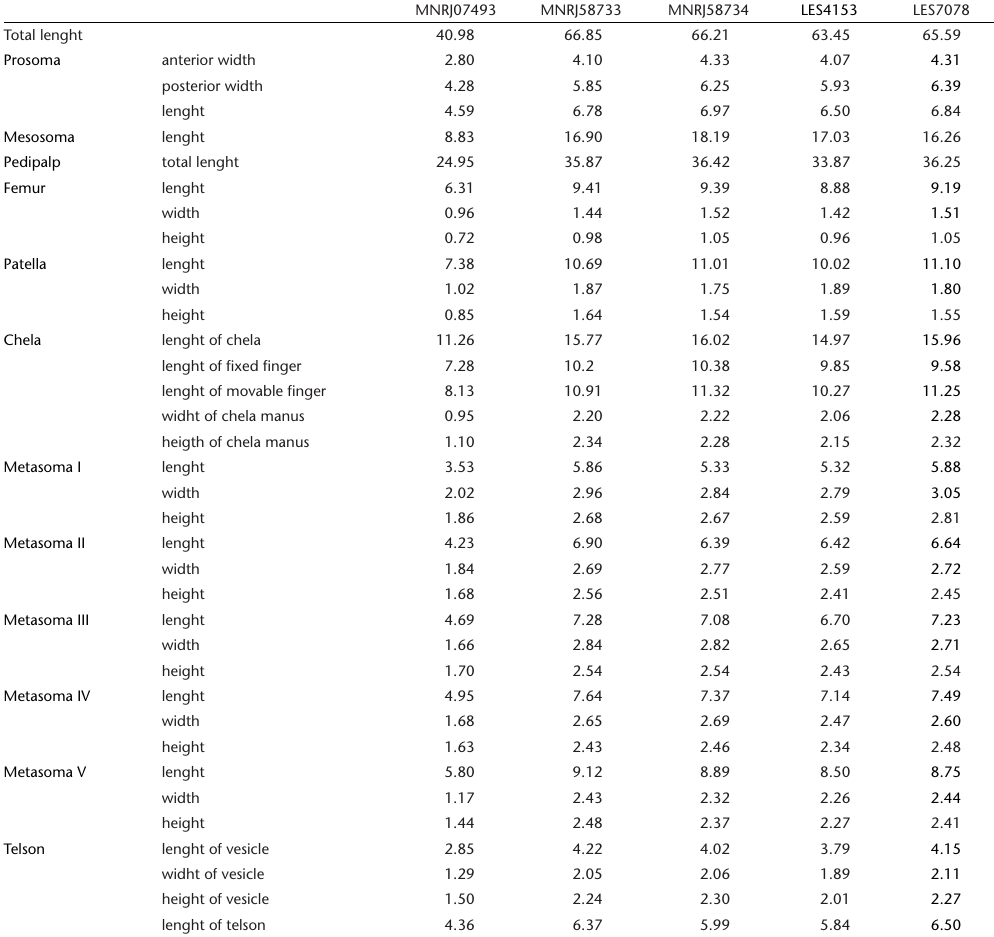
Table 1. Morfometric data of holotype and four adult females of Troglorhopalurus translucidus . The total length measure includes the